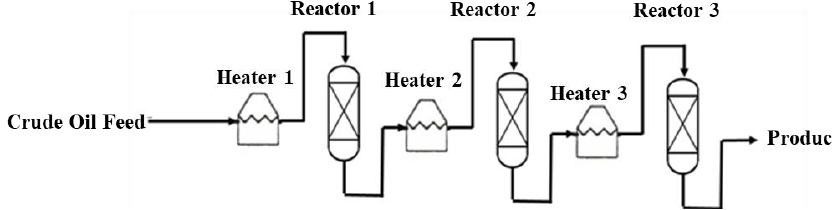
Figure 3. The flowsheet of semi-regenerative process of catalytic decarboxylation.